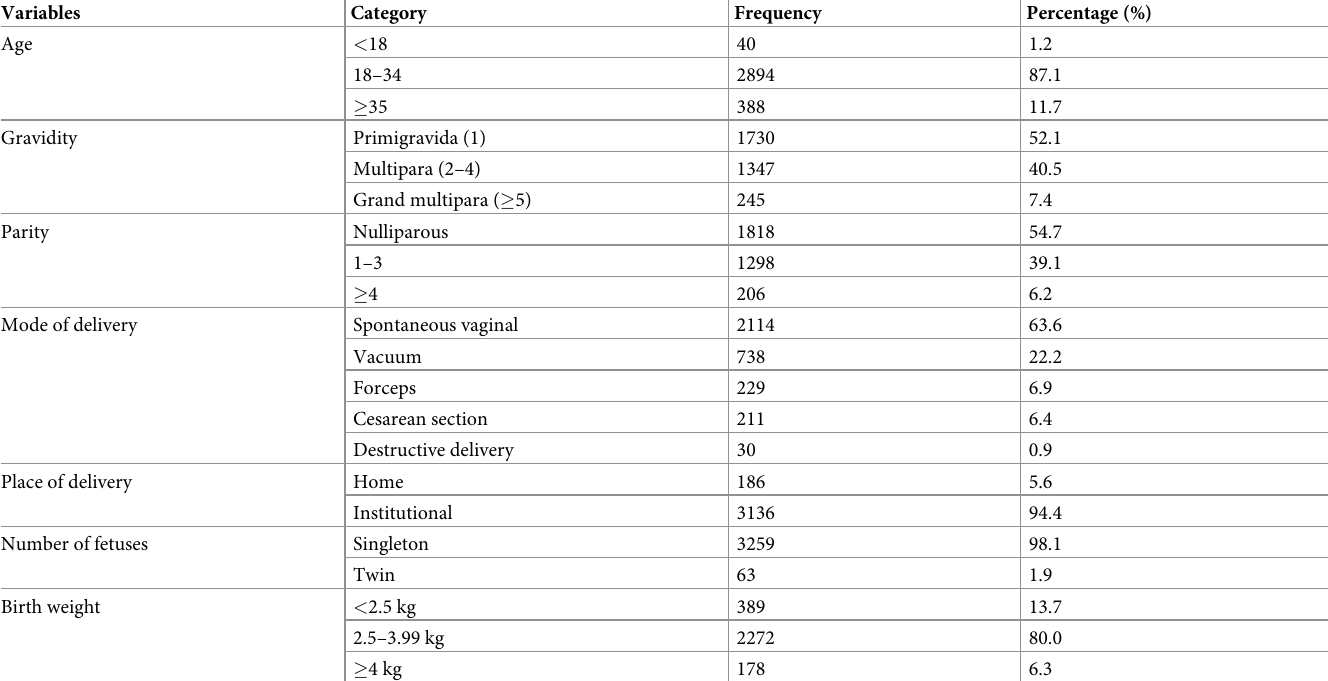
Table 1. Socio-demographic and obstetric characteristics of